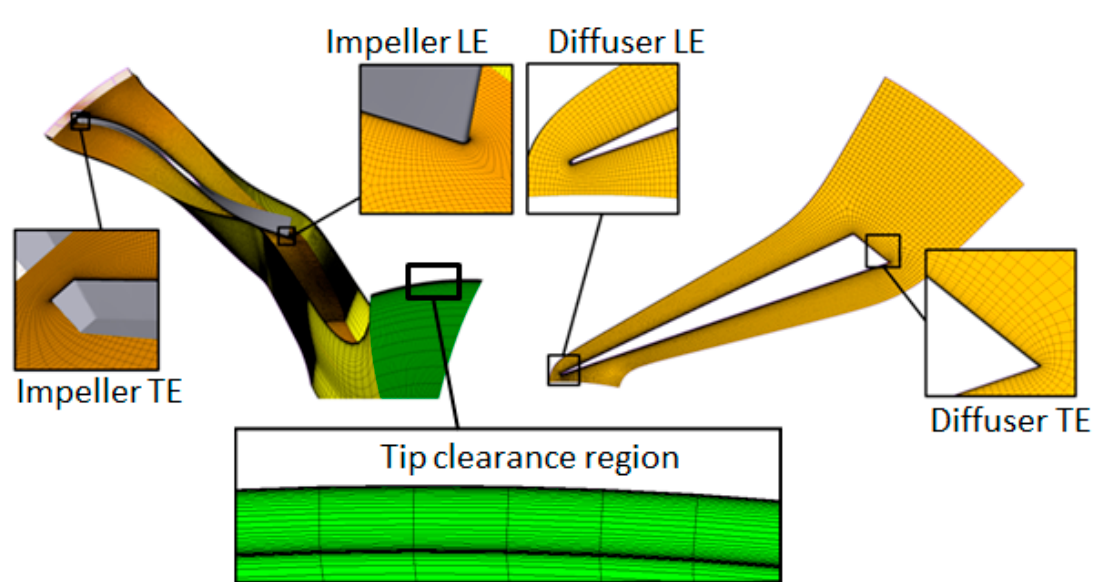
Figure 2. Mesh details of [convergent duct + impeller] (left) and diffuser (right).